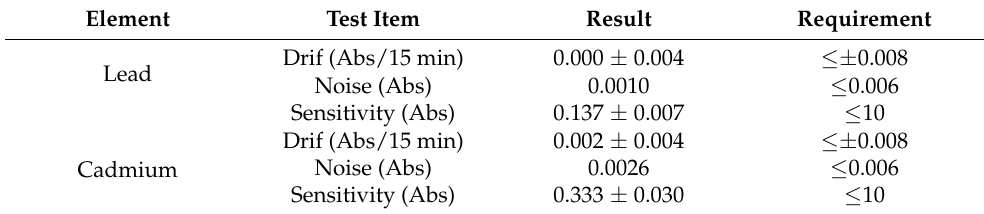
Table 1. Performance test of LCC-HCL (n = 3).